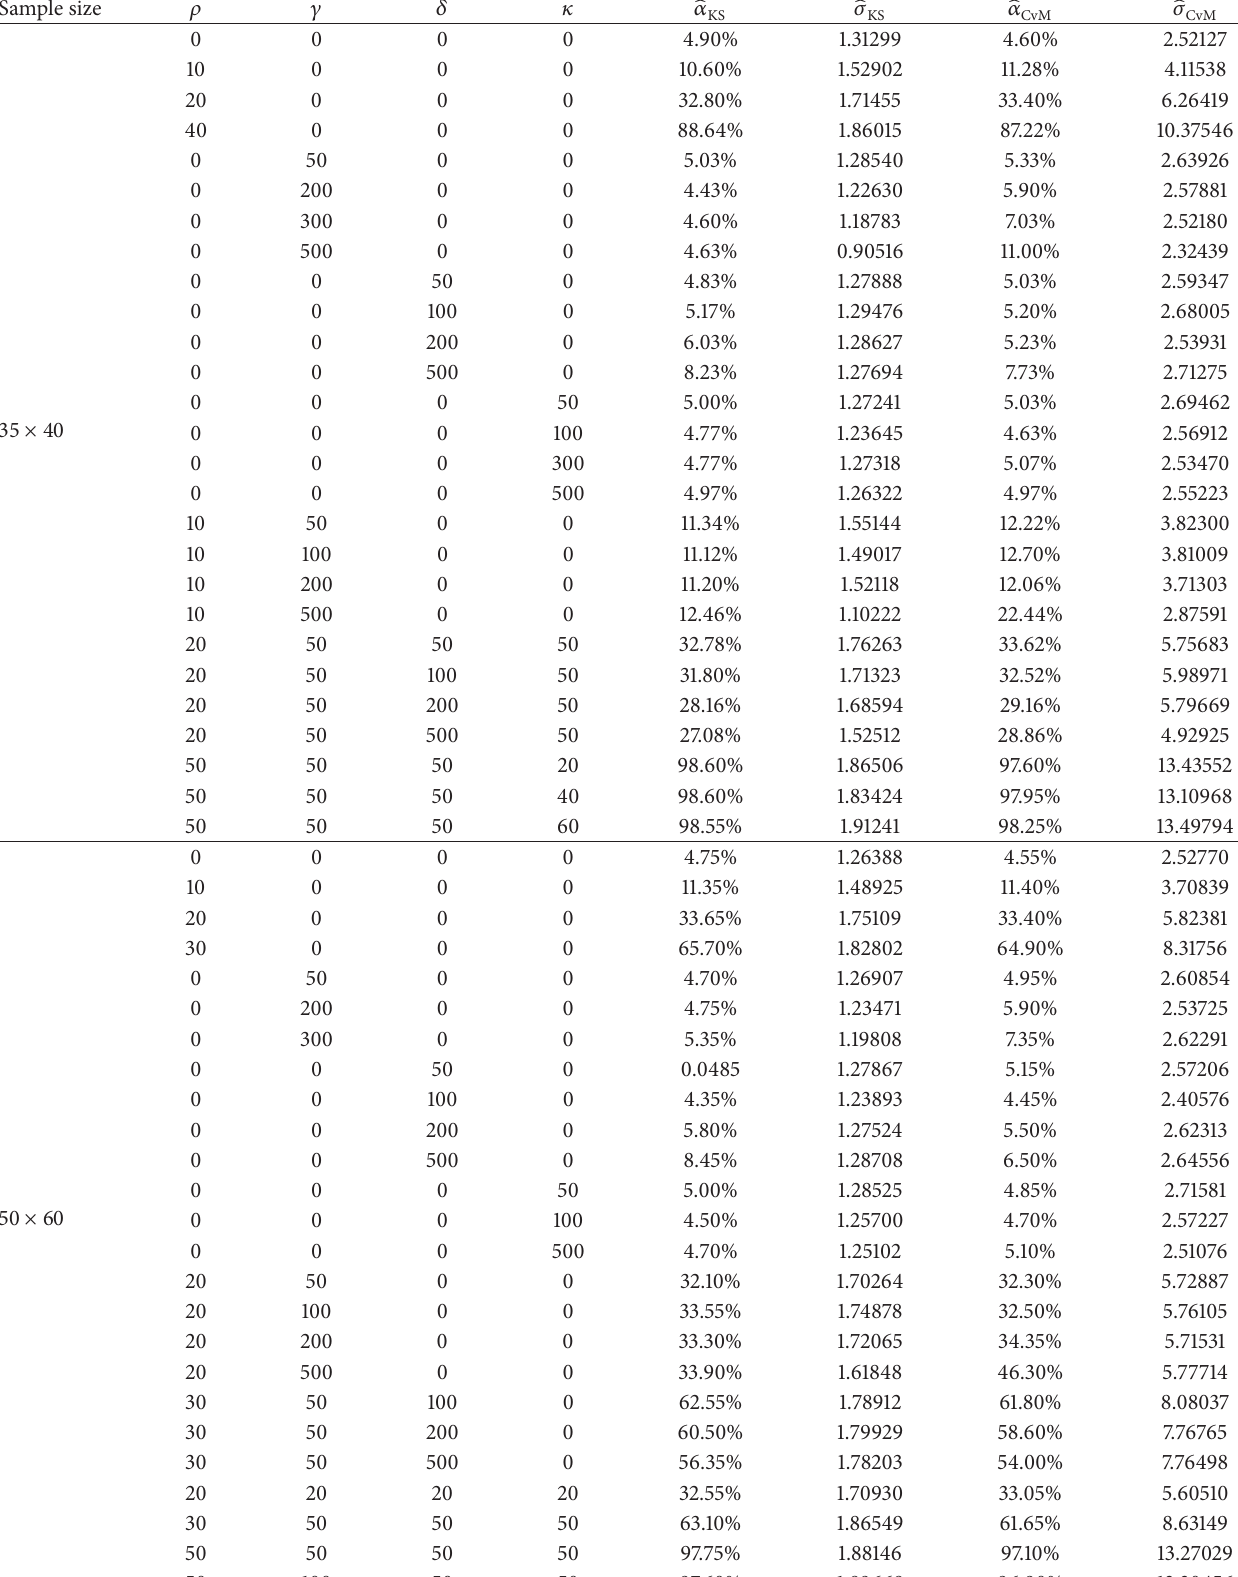
Table 1: The empirical probabilities of rejection of the KS and CvM tests for several selected values of 𝜌 , 𝛾 , 𝛿 , and 𝜅 . The sample sizes are selected to 35 × 40 and 50 × 60 . The simulation results are based on 10000